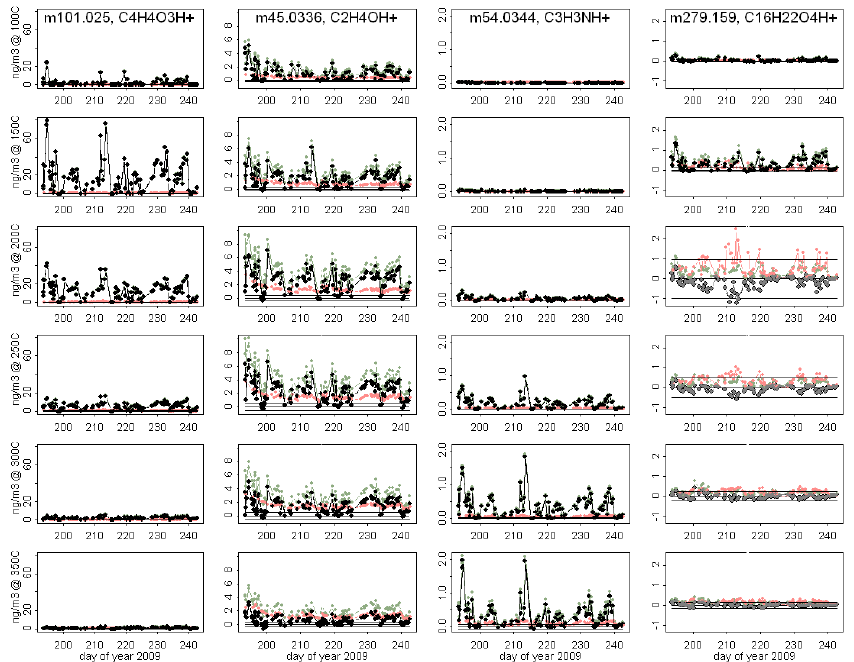
Figure 4. Temporal evolution of the concentration of 4 aerosol compounds. The rows represent the concentration measured at CTD-cell temperatures of 100°C (upper most panels) to 350°C (bottom panels). Aerosol sample data are printed in green, and field blank data are printed in red. The aerosol signal (i.e. the difference between field blank and aerosol sample data) is printed in black. The grey datasets represent aerosol signals that are not significantly above the detection limit. The black lines around the zero-line represent the detection limit. See text for further discussion.